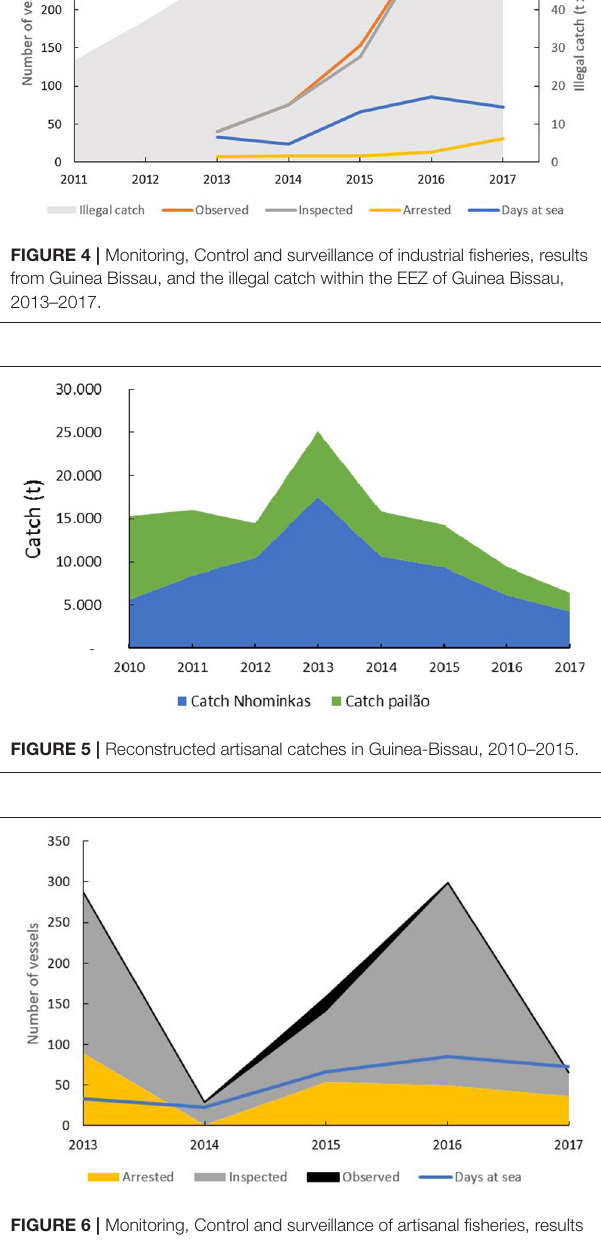
FIGURE 6 | Monitoring, Control and surveillance of artisanal fisheries, results from Guinea Bissau, 2013–2017. MCS data were not available between 2010 and 2012.